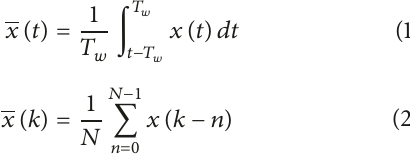
addition, (6) takes on the form of (5) if the sampling time 󳨀→ T s